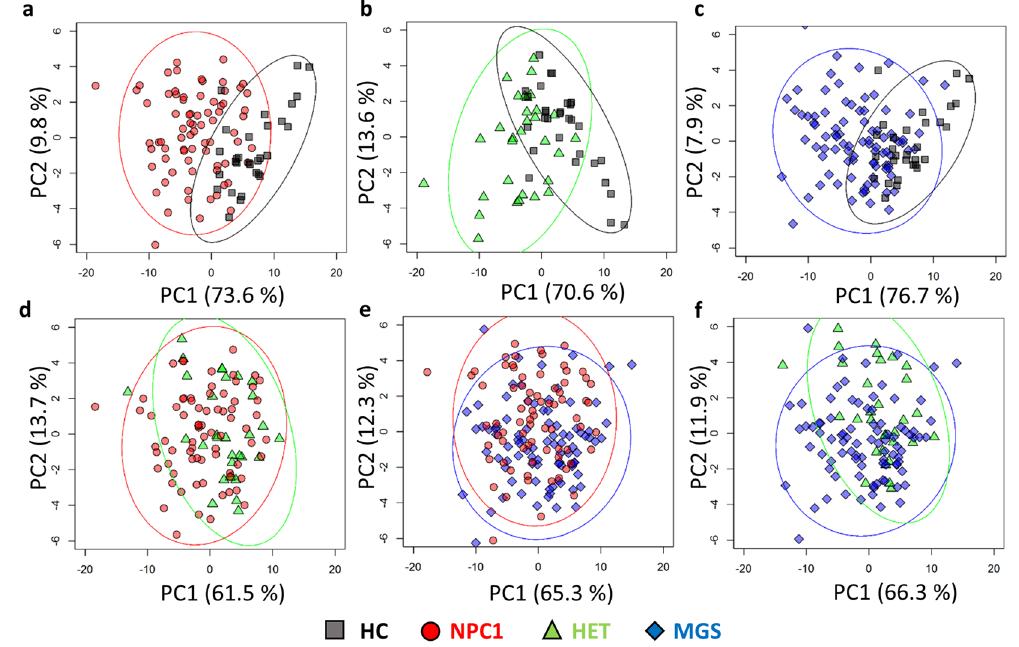
Figure 2. Principal component analysis scores plots (component 1 vs . component 2) of comparisons made on ( a ) HC vs . NPC1, ( b ) HC vs . HET, ( c ) HC vs . MGS, ( d ) NPC1 vs . HET, ( e ) NPC1 vs . MGS, and ( f ) and MGS vs . HET.